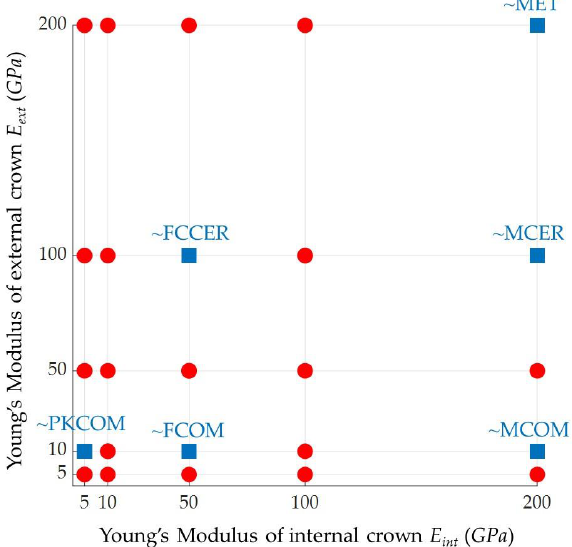
Figure 17. Combinations of Young ’s modulus, E , in GPa for all study cases. Red balls: generic ma- terials. Blue squares: studied cases with mechanical properties close to standard